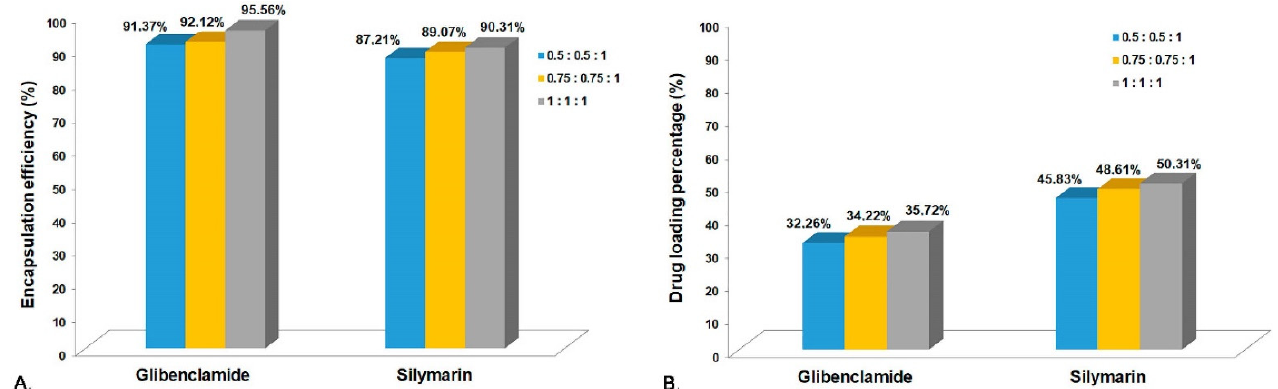
Figure 2. ( A ) Encapsulation efficiency for CS-Gli-Sil; ( B ) drug loading percentage for CS-Gli-Sil.